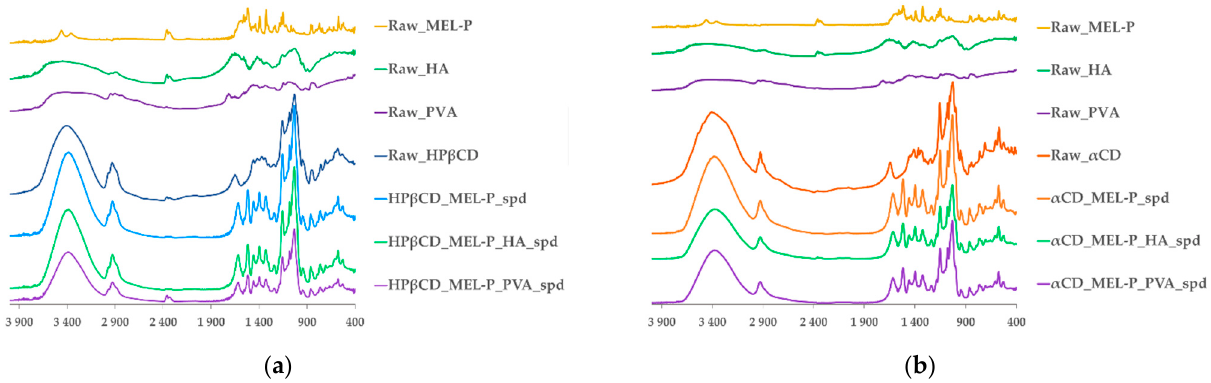
Figure 6. FT-IR spectra of the raw materials and: ( a ) the HP β CD-containing and ( b ) the α CD-containing spray dried